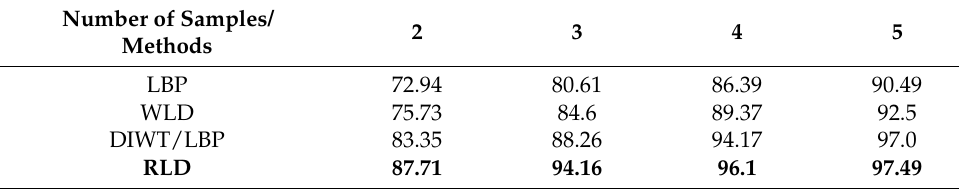
Table 1. Average recognition rates for the ORL face database (%).